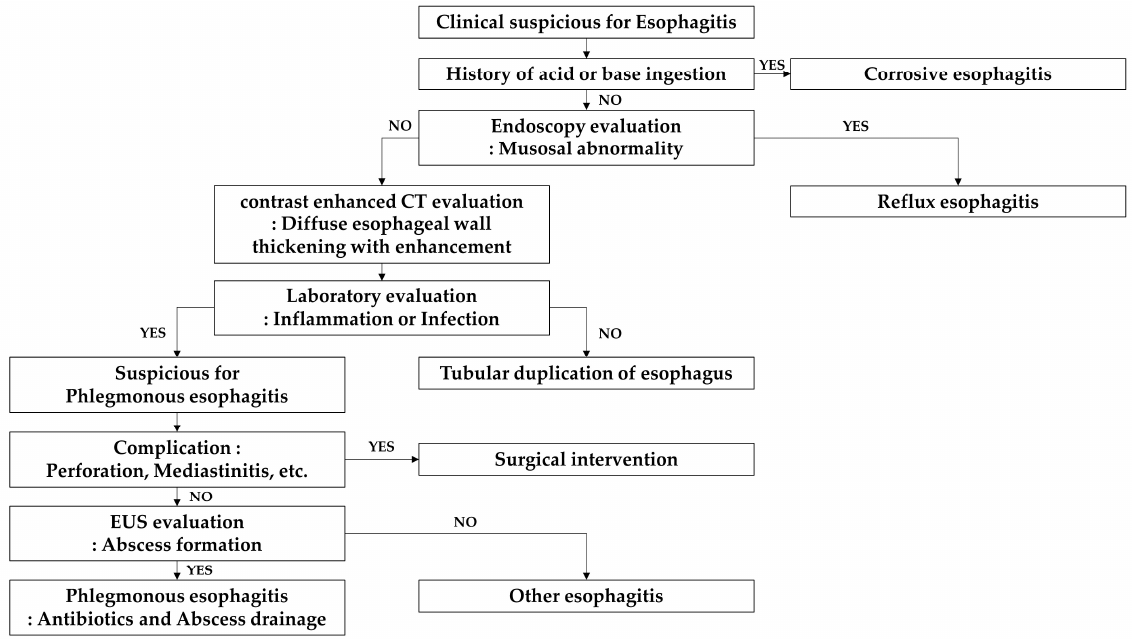
Figure 8. Flow chart of diagnosis of esophagitis with CT examination and EUS.